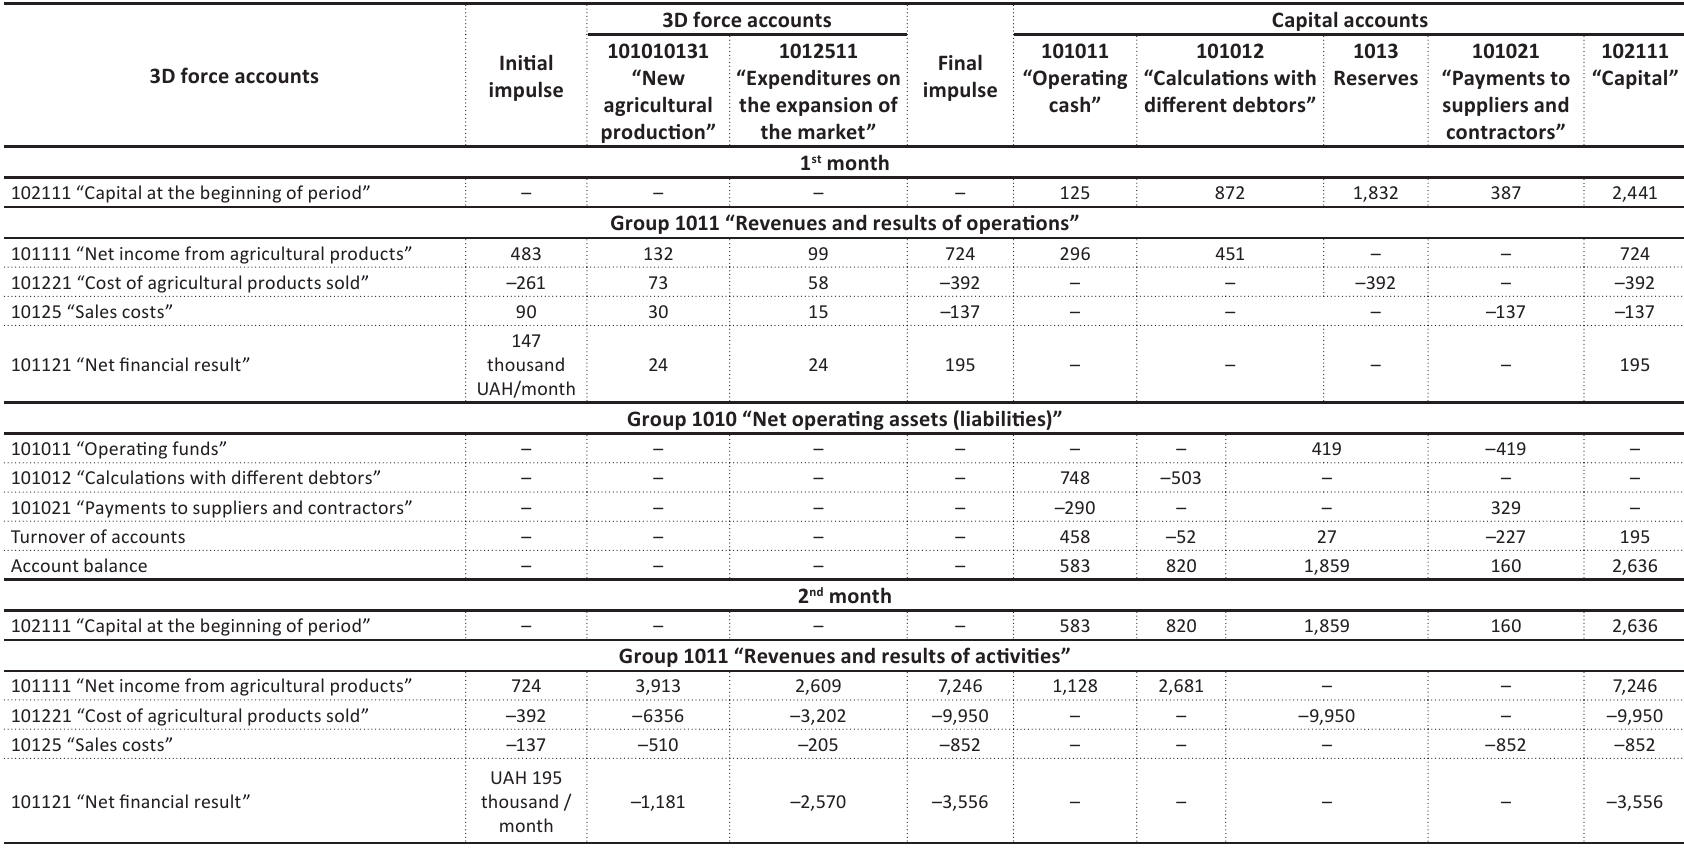
Source: Developed by the authors based on SMIDA (2020) and Samusenko